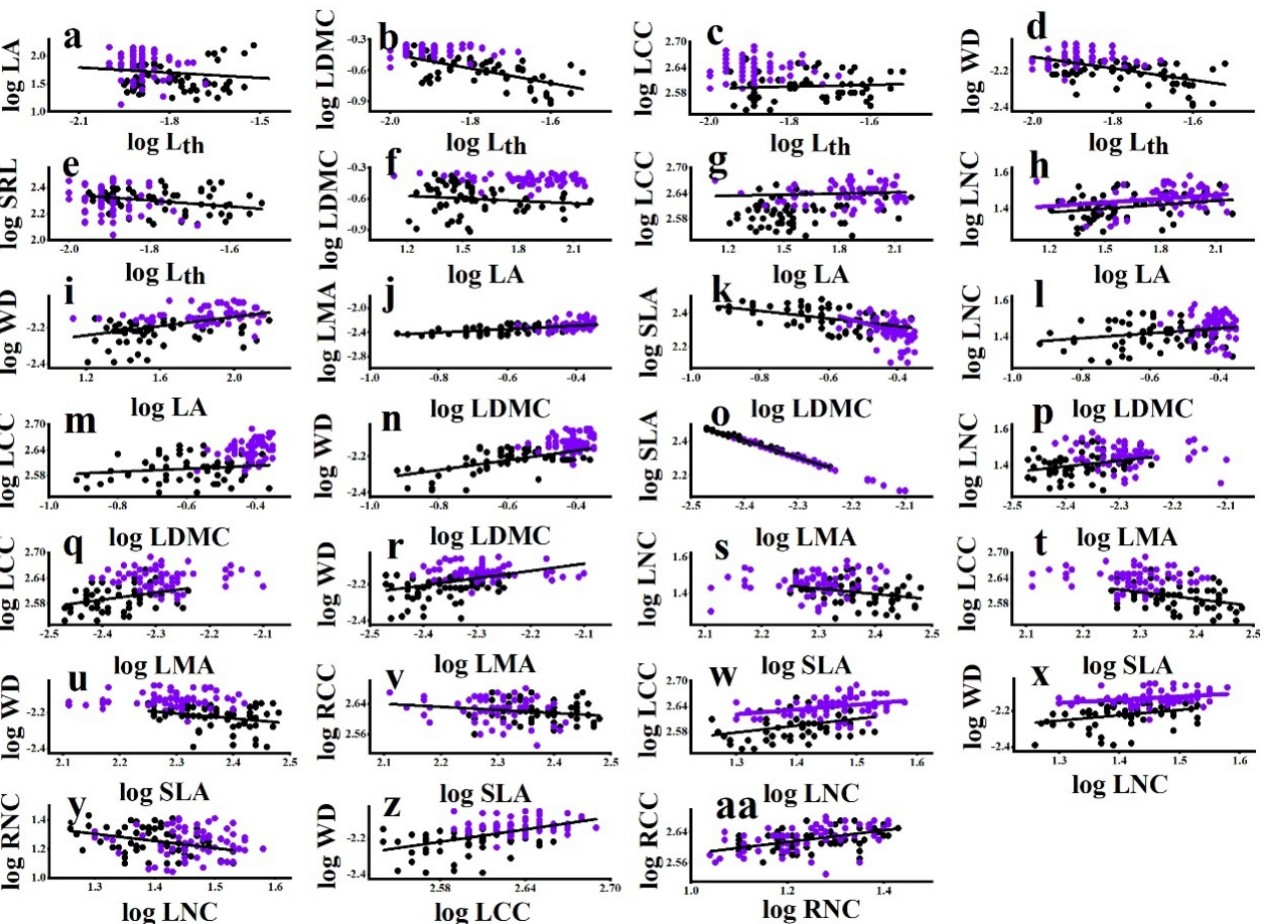
Figure 3. Bivariate trait relationships among liana and tree species from the temperate forest. Standardized Major Axis (SMA) coefficients for differences in slope and shifts in elevation between lifeforms are given in Table S3. Filled black dots represent lianas and purple empty dots trees. Differences between lianas and trees are indicated by a black solid line and a purple solid line, respectively. The single solid line represents a significant association but no differences between lianas and trees. For explanation of abbreviations, see Table 1.